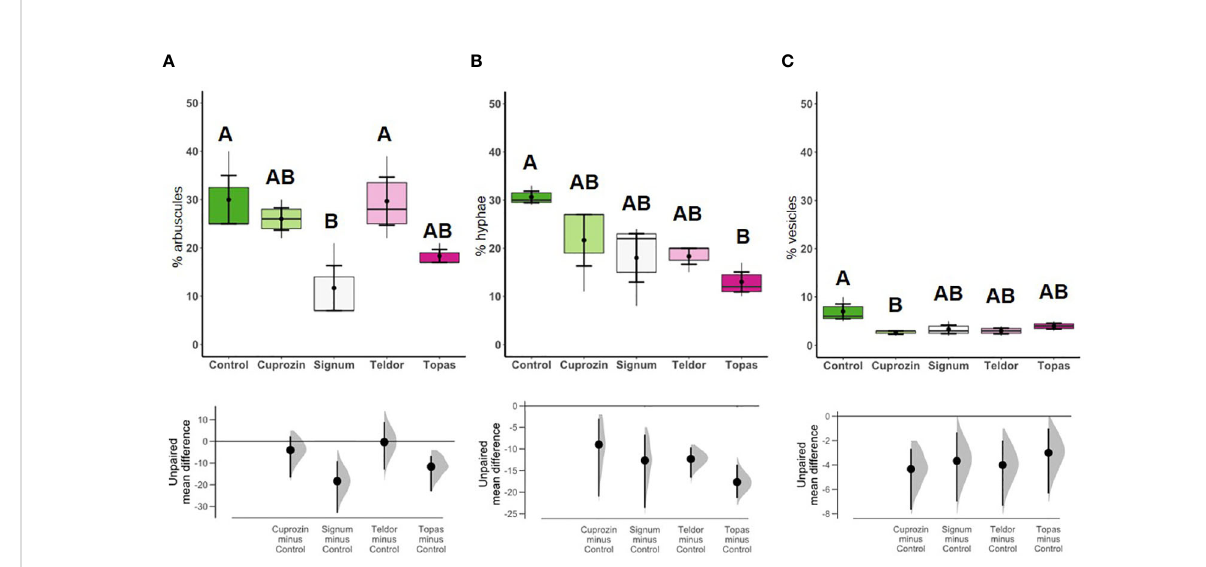
FIGURE 2 Root colonization of tomato plants by AMF structures after 90 days: arbuscules (A) , intraradical hyphae (B) and vesicles (C) . The upper part of the fi gures are box-plots containing the average values and standard errors. Treatments with the same letter for each variable are not statistically signi fi cant by the Tukey post-hoc test (p < 0.05, details of ANOVA model are in Supplementary Material). The bottom part of the fi gure are the effect sizes of the treatments in relation to the